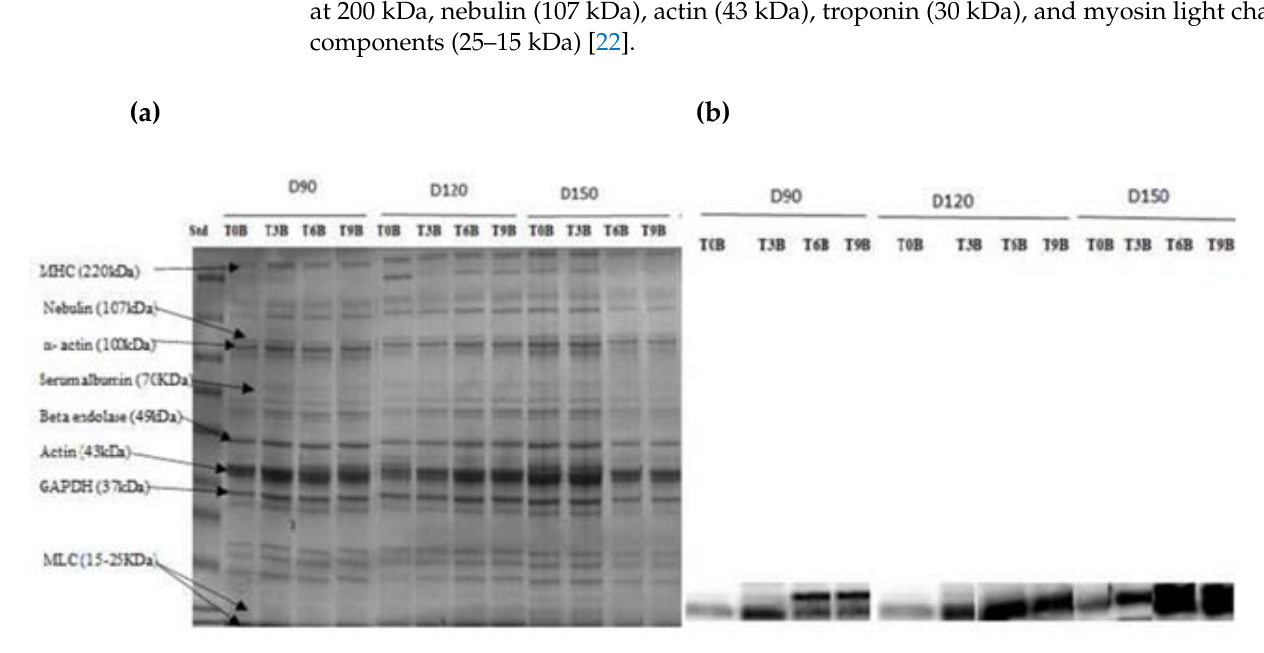
Figure 7. (a) SDS-polyacrylamide gel electrophoresis, (b) immunoblotting against protein carbonyl groups in bled African catfish fillet from three different stock densities during refrigerated storage at +4 °C. T: Time, B: bled, D: density.